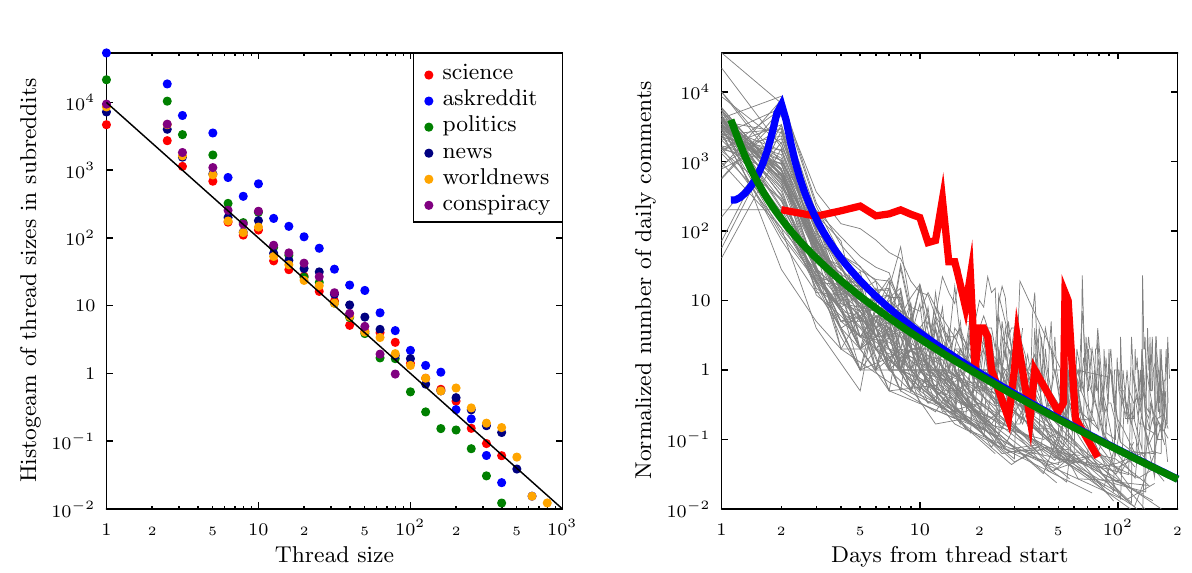
Figure 5. ( Left panel ): Histogram of the overall thread size distribution for threads containing vaccination related keywords within each of the topmost subreddits. The black line shows power–law behavior with an exponent of − 2 for comparison. ( Right panel ): Time evolution of the total number of daily comments (not just those containing vaccination related keywords) within the topmost threads containing vaccination related keywords. The time is counted from the day the thread was initiated. For most of the threads, the activity falls very rapidly in the range of 5–10 days, after which typically single comments appear, separated by increasingly long periods of thread inactivity. Green and blue lines show examples of log-Cauchy distributions (green for threads which start ‘immediately’, blue for threads that are ‘noticed’ on the next calendar day.) The red line indicates an example of a thread which is an outlier, showing high and relatively constant activity for over 12 days. The thread, appearing in the ‘ conspiracy ’ subreddit, was titled ‘ Vaccines *DO* Cause Autism According to Pro-Vaccine Expert: The sworn affidavit states that he told government officials about the vaccine/autism link long ago, but they kept it secret and promptly fired him